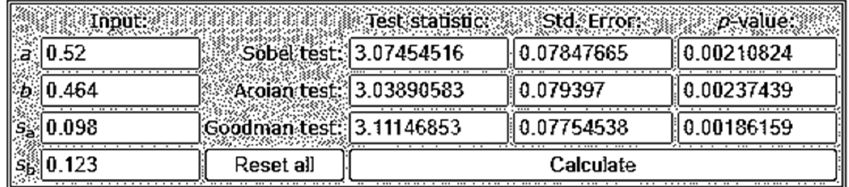
Fig. 4. The result of Sobel test for mediating role of perceived risk for perceived usefulness and consumer buying decision